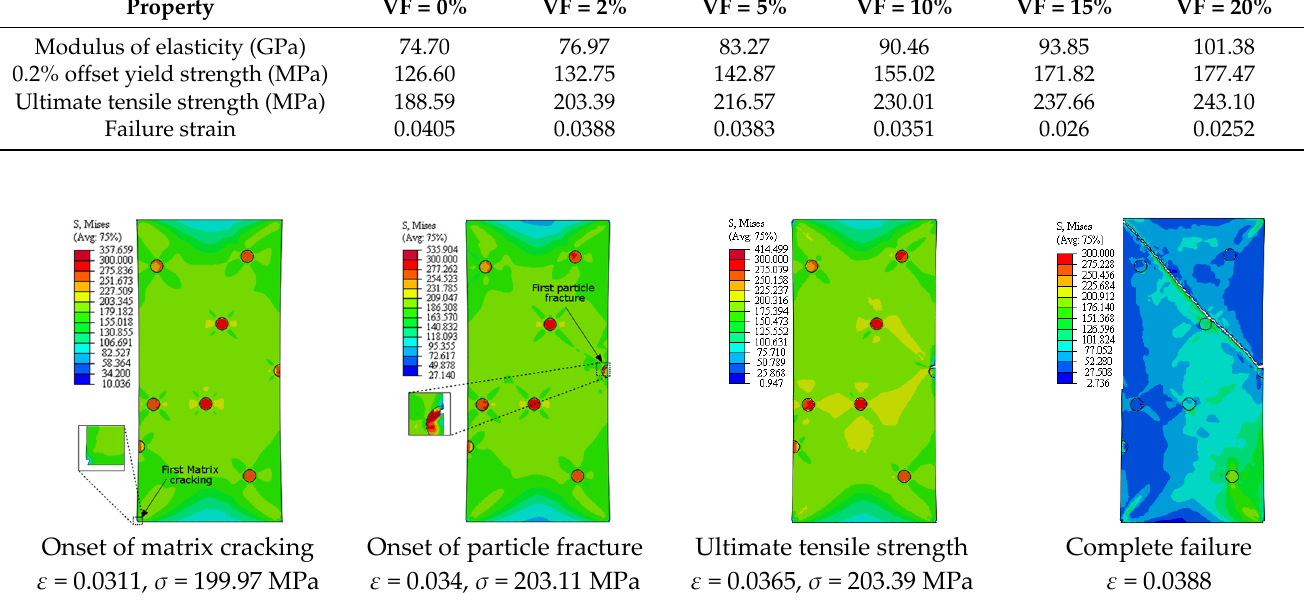
Figure 6. Failure propagation and von Mises stress distribution of A359/SiC composite at 2% VF (PS = 10 µm).